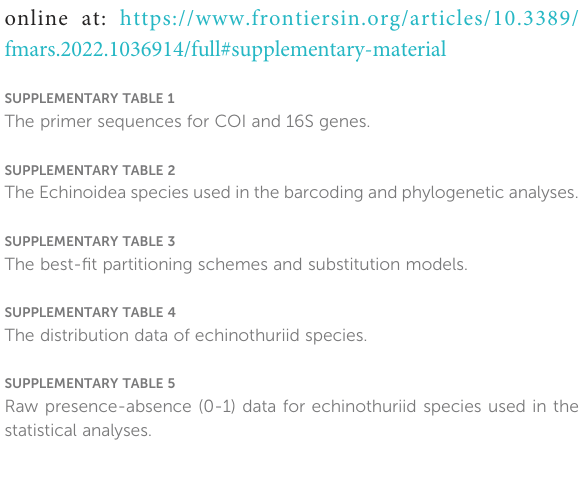
SUPPLEMENTARY TABLE 3 The best- fi t partitioning schemes and substitution